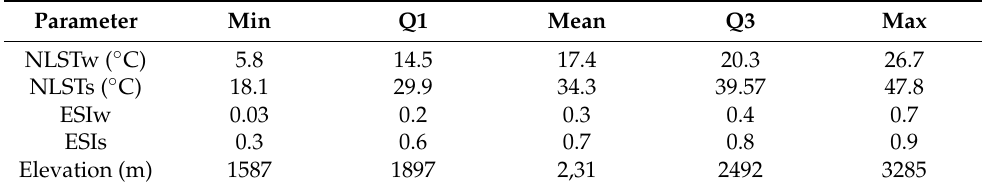
Table 2. Descriptive data of normalized surface temperature in winter and summer (NLSTw and NLSTs), and of evaporative stress index in winter and summer (ESIw and ESIs). Q1 and Q3 are quartiles of the data